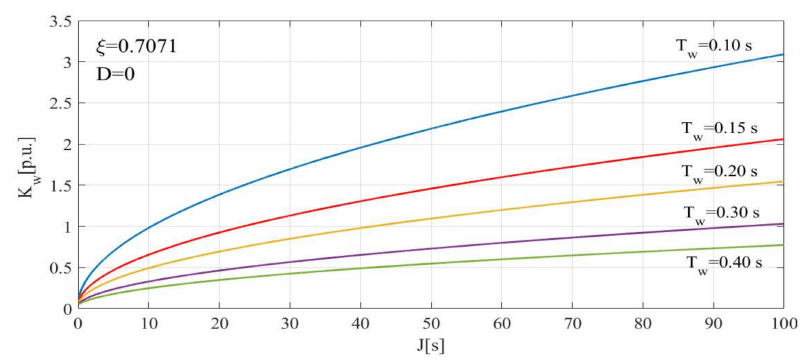
Figure 10. K w as a function of J for different T w values.